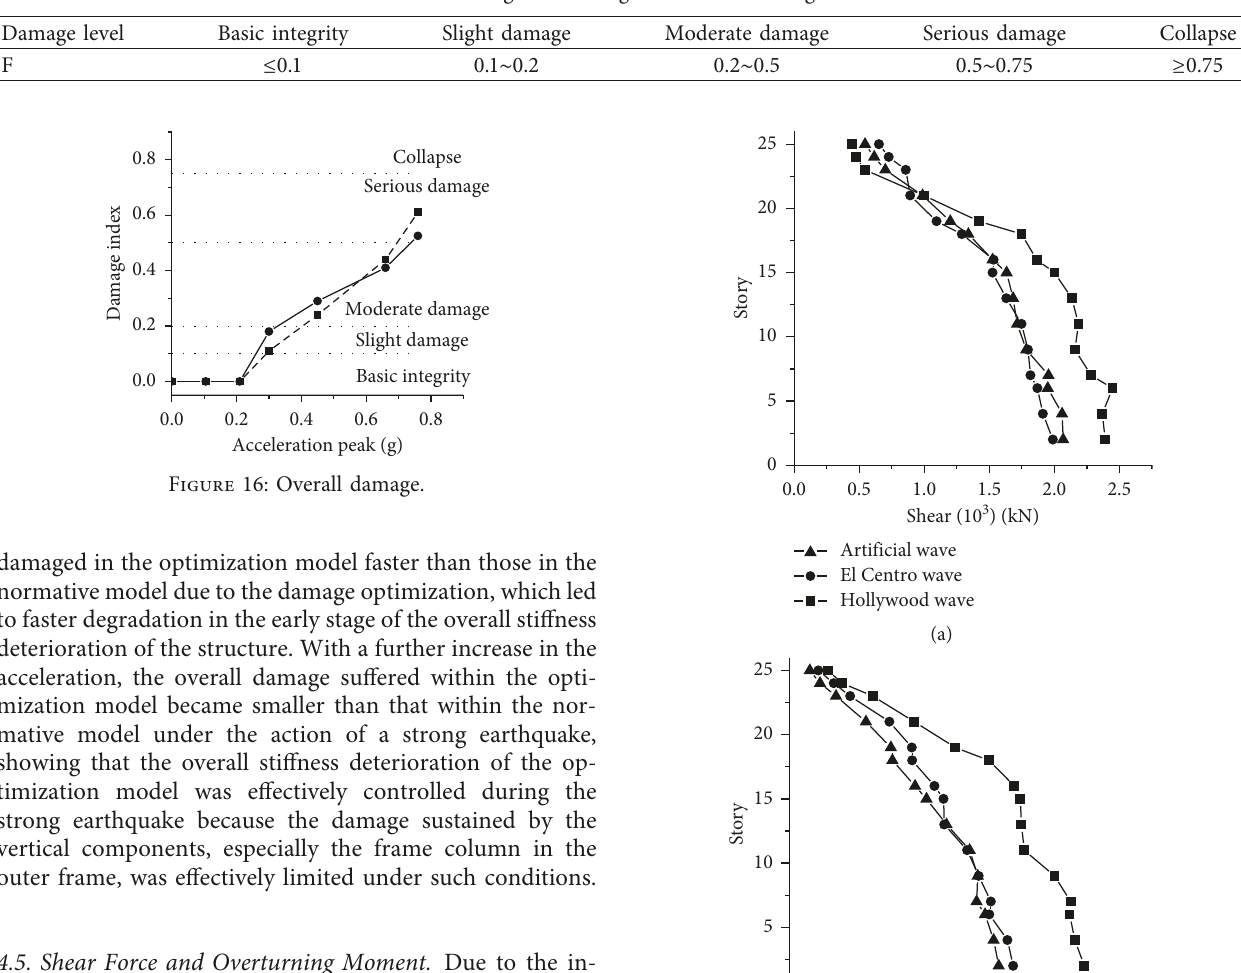
Table 14: Damage index range at different damage levels.